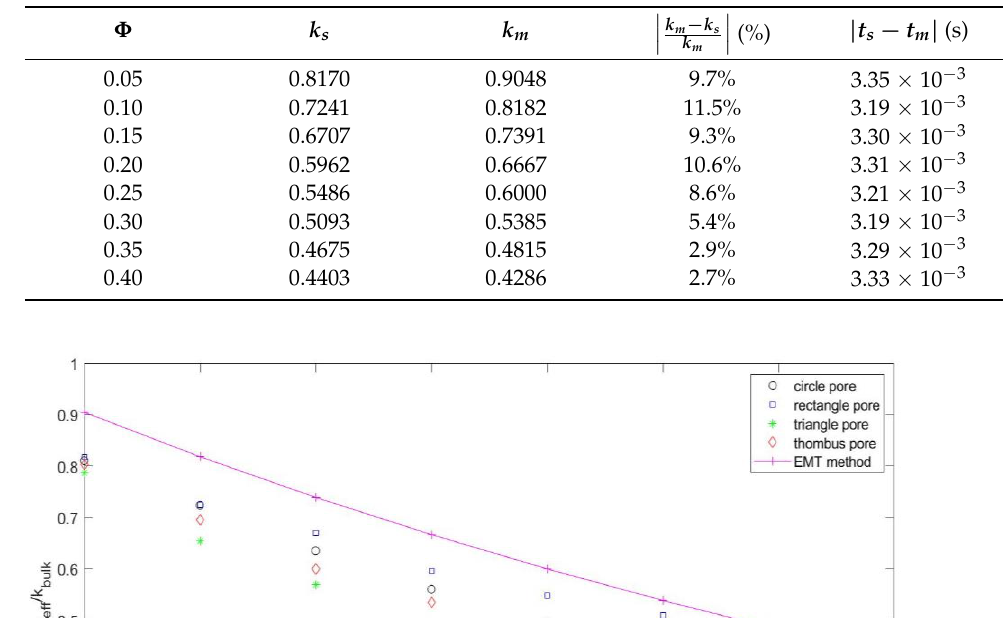
Table 2. The effective thermal conductivity of rectangle pores compared with the EMT method.